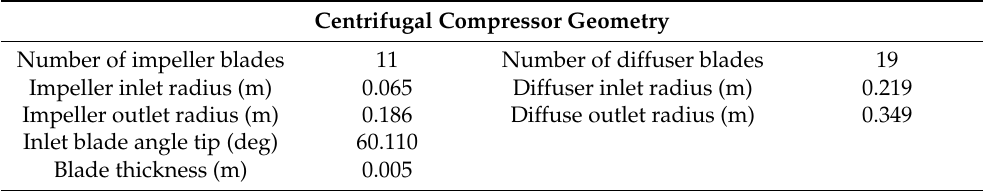
Table 4. Geometry of the designed compressor.